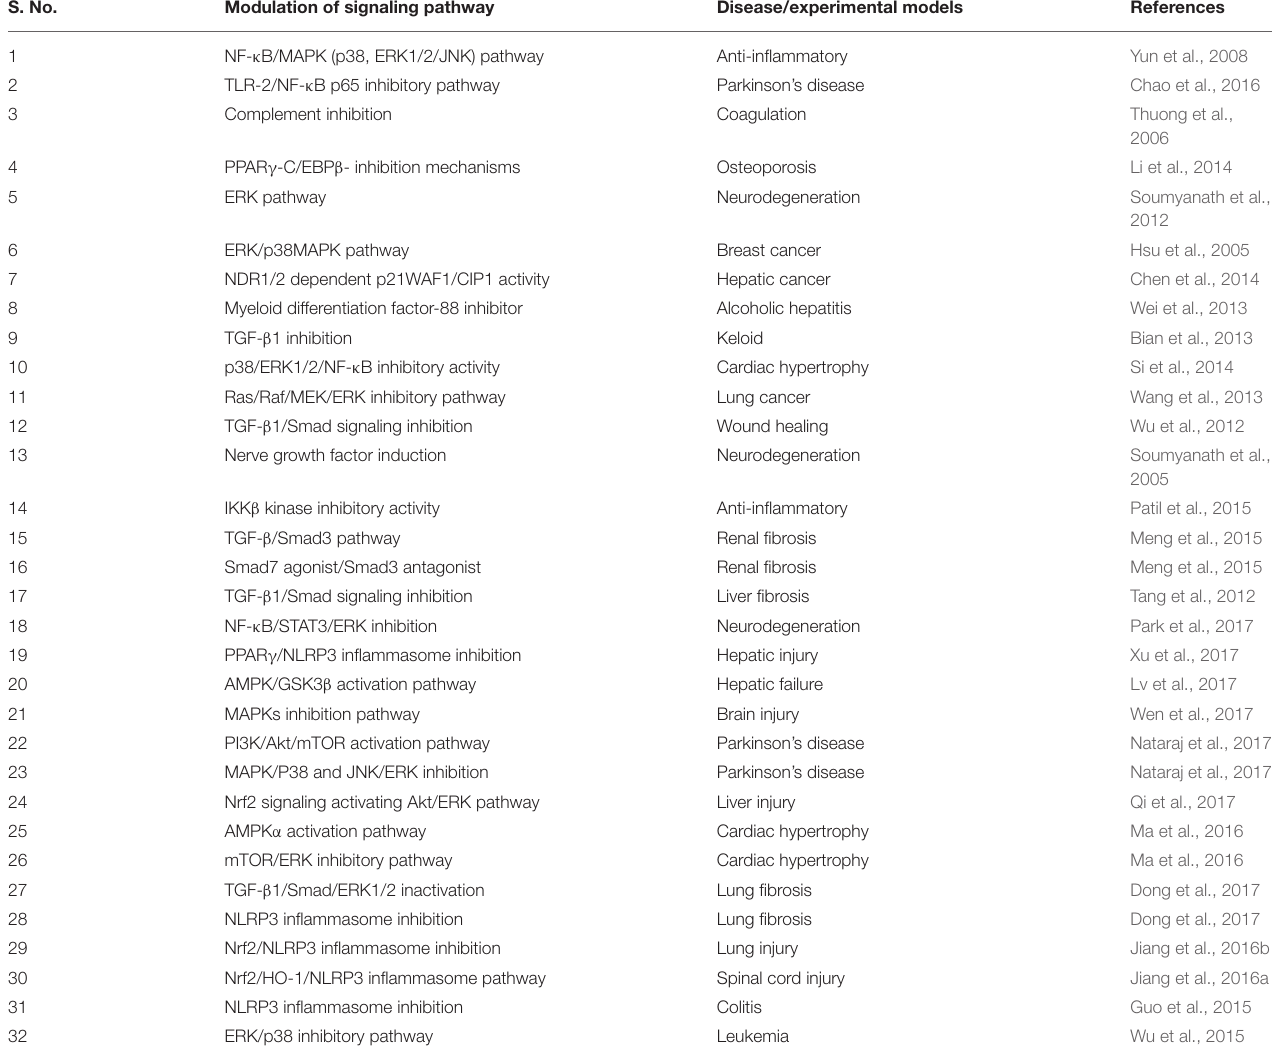
TABLE 6 | The cell signaling pathway modulated by asiatic acid. S.